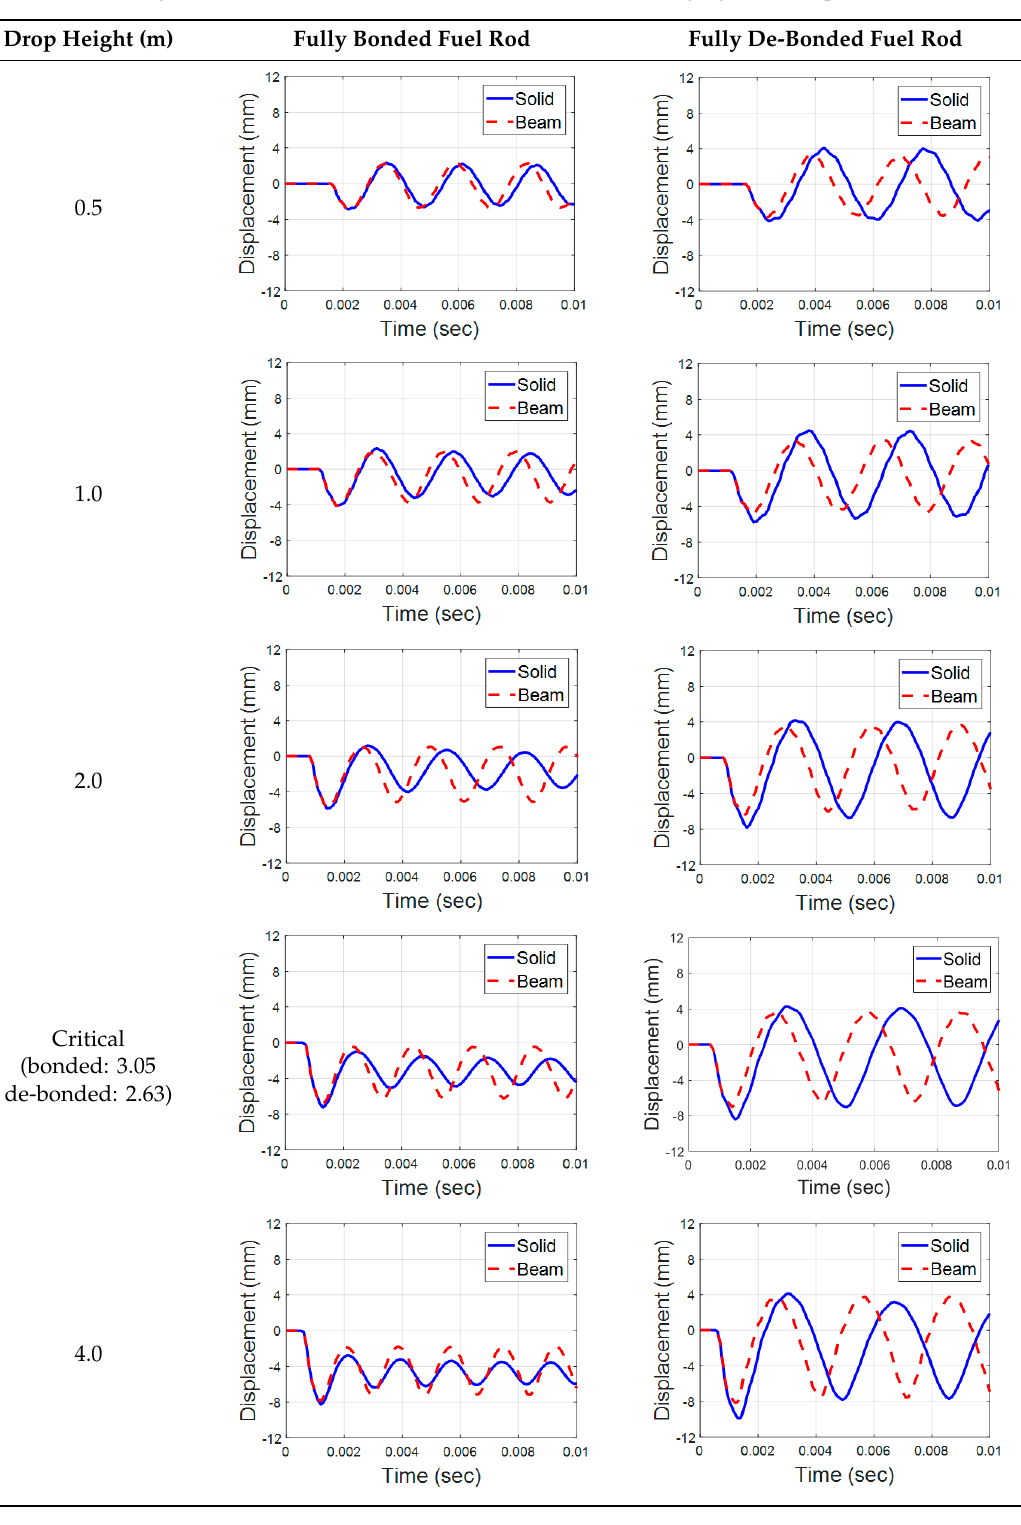
Table 8. History of the maximum deflection of fuel rods calculated by dynamic impact